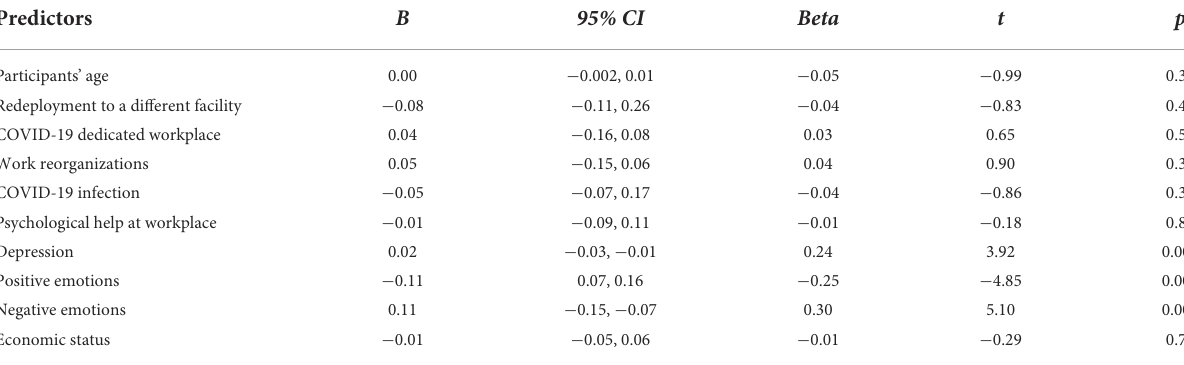
TABLE 6 Positive and negative emotions, depression symptoms, and economic status as predictors of